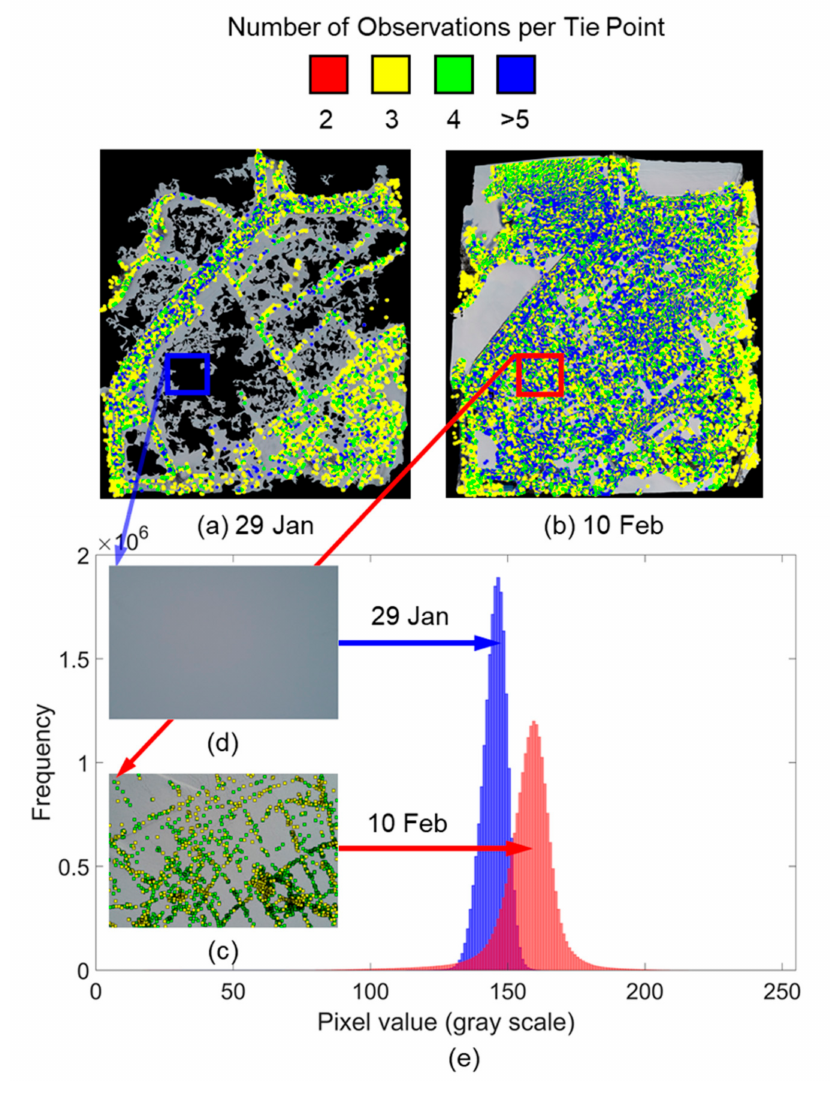
Figure 14. The location of the tie points that were identified by the program that were used in this study for the date of ( a , c ) 29 January 2020 (9 p.m.) and ( b , d ) 10 February 2020 (3 p.m.). ( e ) Gray histogram of photo taken on 29 January and 10 February at the same position, respectively. Black area in ( a ) and ( b ) represents the area where photographs could not be tied due to the lack of tie